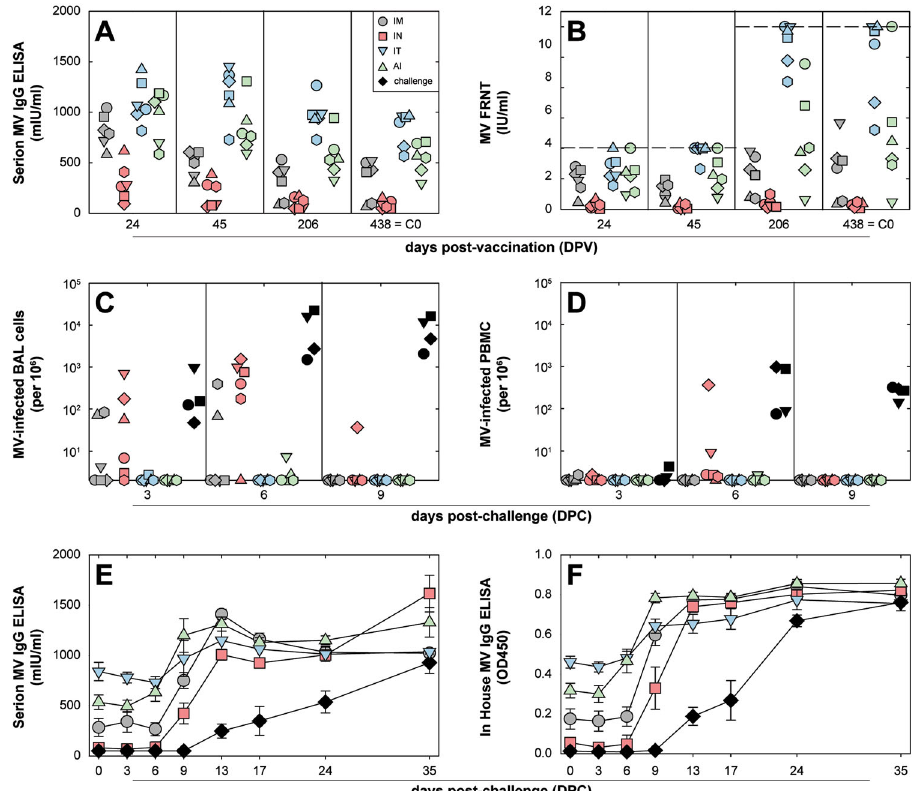
Fig. 5 Protection. Immunization of non-human primates with rMV EZ EGFP(3) via four different routes of administration induced varying levels of protection to IT challenge with wild-type MV strain Bilthoven 14 MPV. In panels a – d symbols represent individual animals: a , b show MV- speci fi c serum antibody levels before challenge as measured by ELISA or FRNT, respectively (in panel b the dotted lines show the upper limit of detection of the two assays that were performed); c , d show frequencies of wild-type MV-infected BAL cells and PBMC after challenge infection, respectively. Panels e , f show MV-speci fi c serum antibody levels after challenge, demonstrating accelerated secondary immune responses in all vaccinated animals as compared to slow primary responses in the challenge control animals (means ± standard error per group). Symbol colors and shapes for vaccinated animals are identical to those in Figs. 1 – 4, black symbols represent challenge